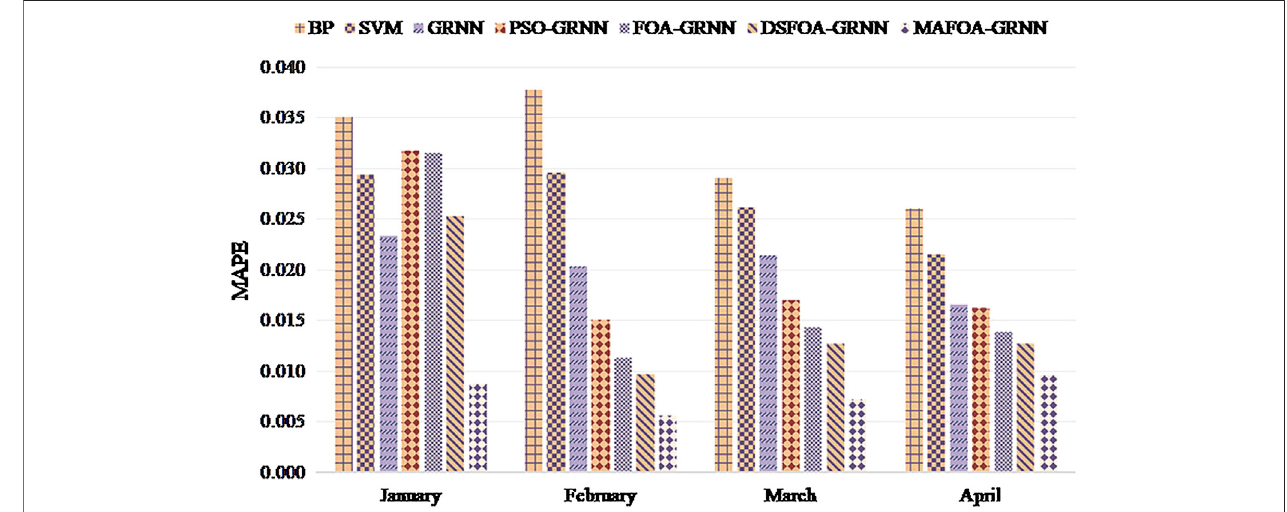
FIGURE 9 | Performance comparison of models in terms of MAPE